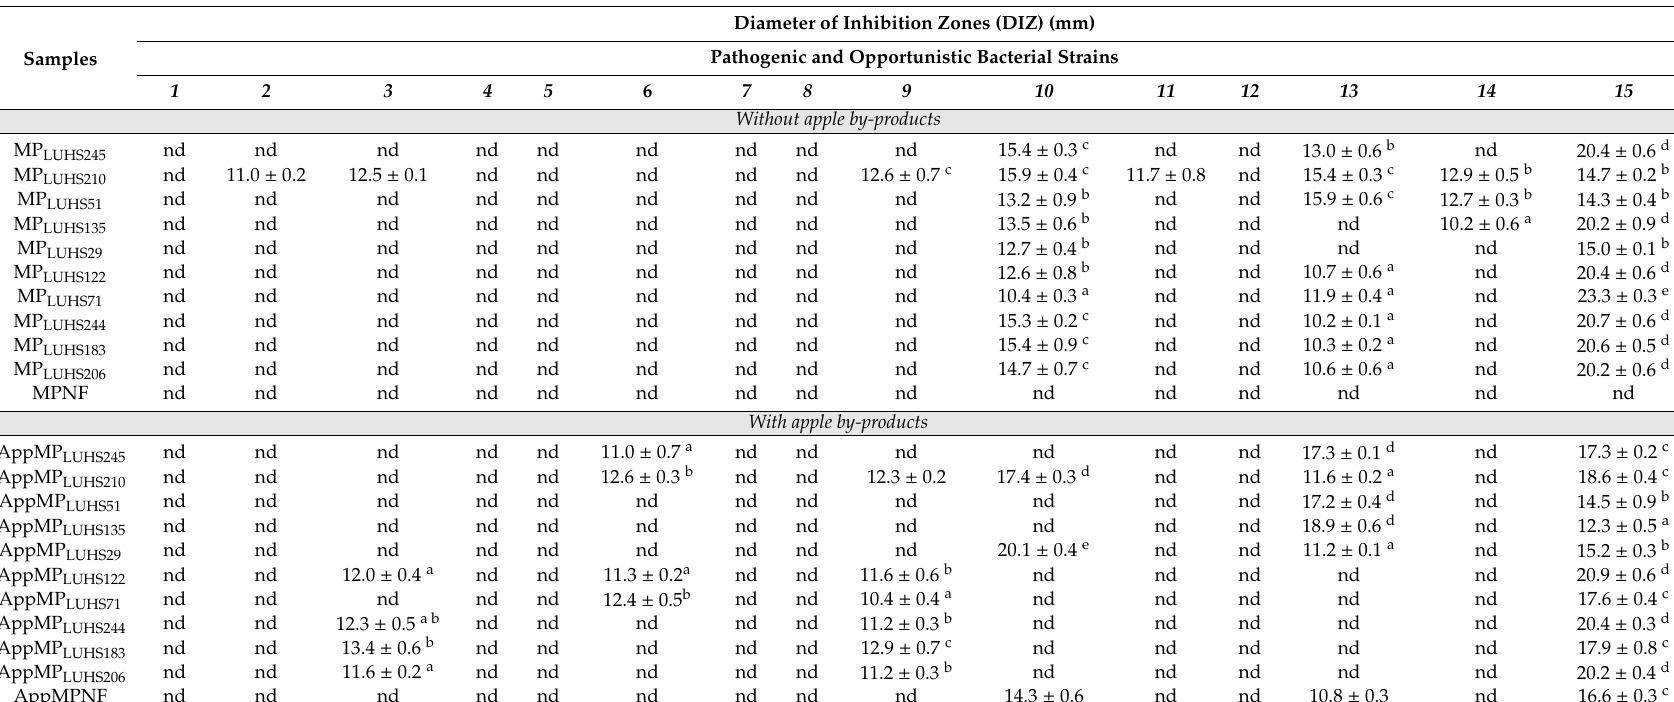
Table 2. Average values and standard deviations (Mean ± STDV) ( n = 3) of the diameter of inhibition zones (mm) in the milk permeate (MP) (0 h) and final fermented beverages (24 h), without and with addition of apple by-products, against 15 pathogenic and opportunistic bacterial